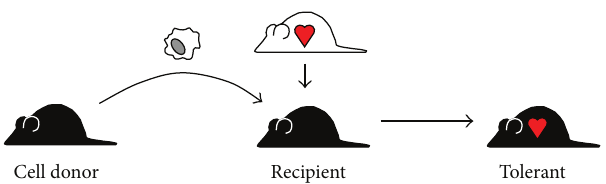
Figure 1: Adoptive transfer of immunoregulatory function. Trans- plantation of cells with immunoregulatory function to control unwanted immune reactions is not a new proposition. From the earliest discovery that transferring regulatory cells from tolerant to nontolerant animals could establish tolerance in the recipient, it was suggested that the same principle could be applied therapeutically in man. However, while adoptive transfer became a common exper- imental practice, its translation to the clinic met many obstacles, not least the difficulty of identifying and isolating human regulatory